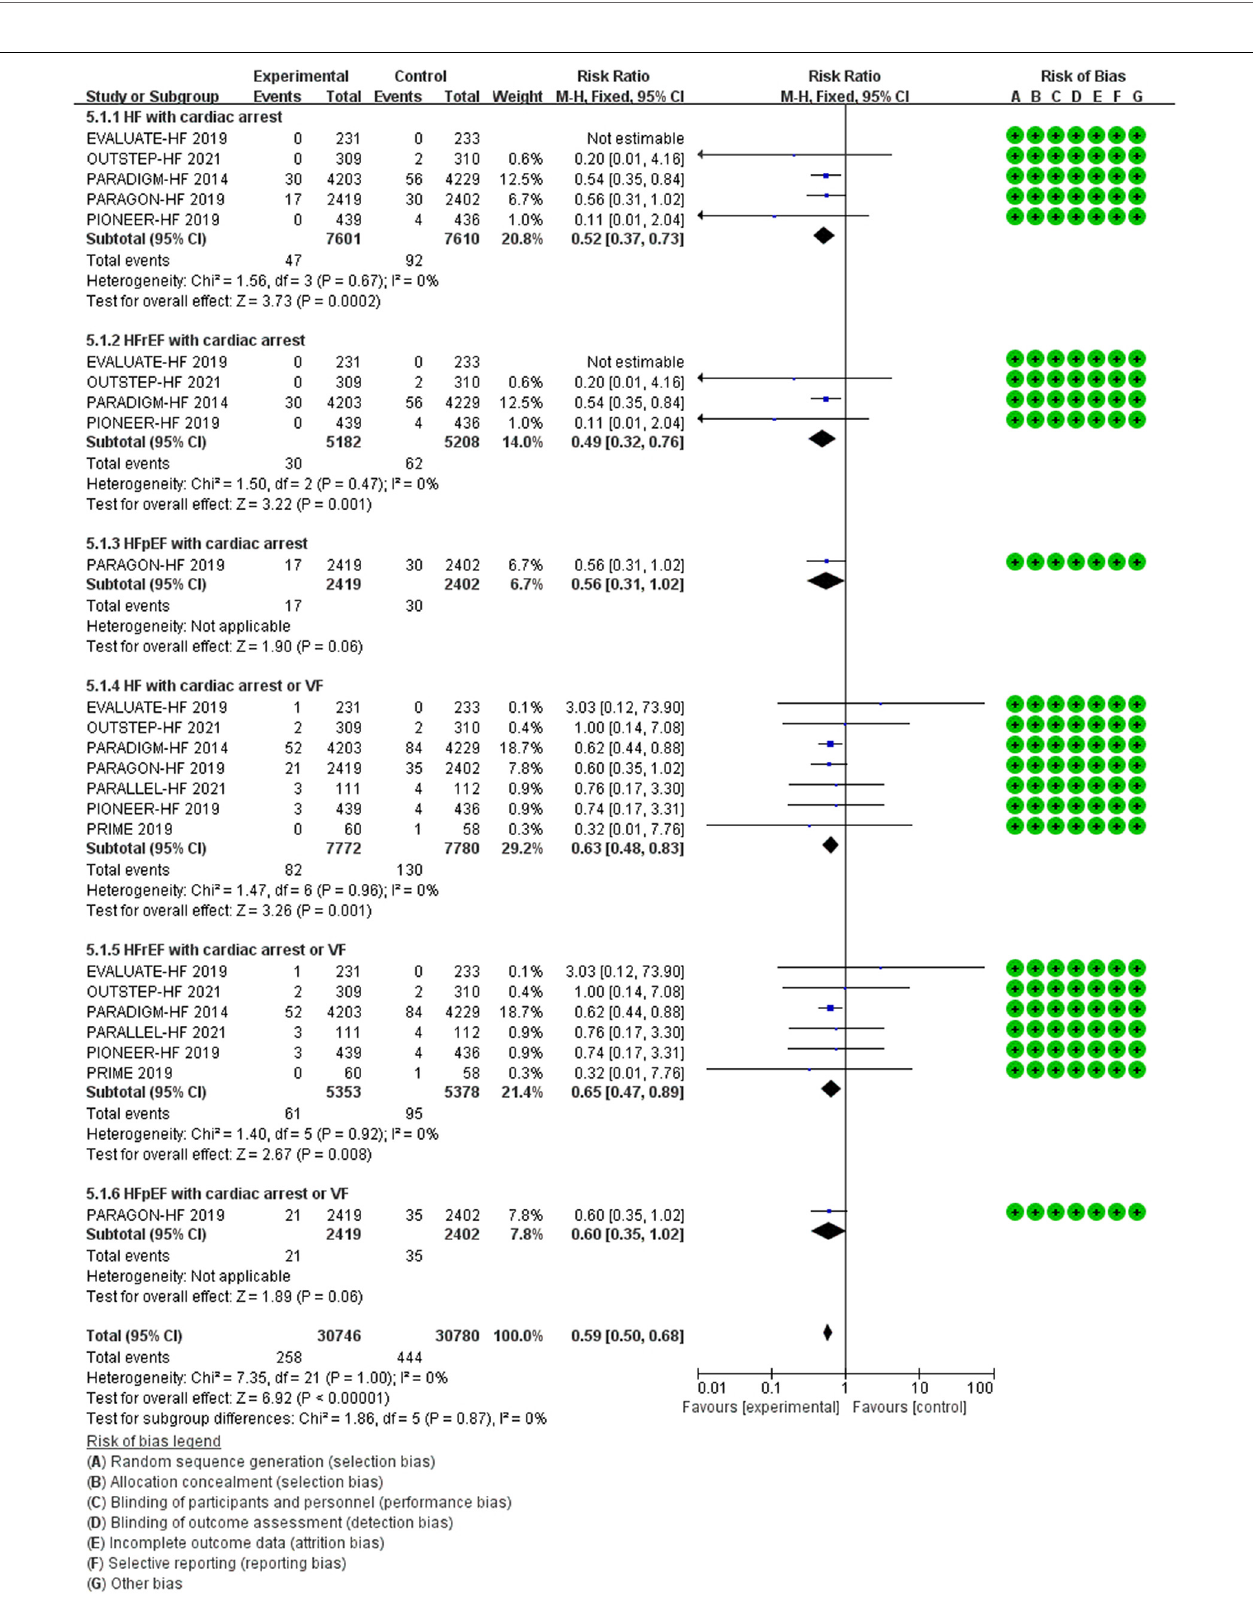
FIGURE 8 | The efficacy of SV compared to ACEI/ARB on Cardiac arrest or Cardiac arrest combined VF.